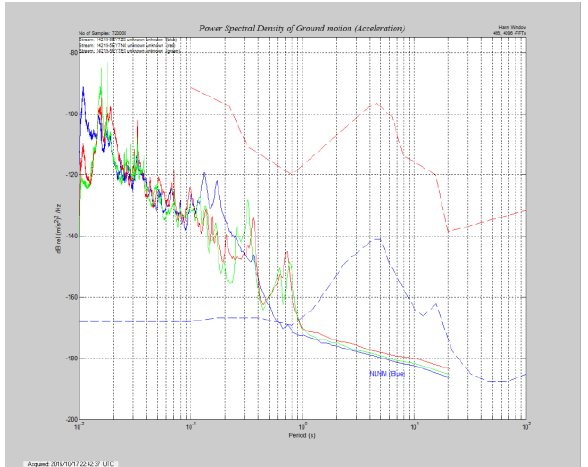
Figure 12. Spectrum